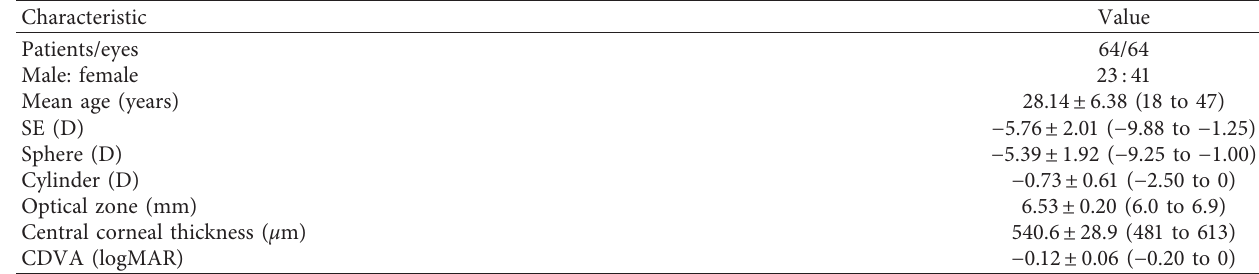
Table 1: Demographic characteristics.